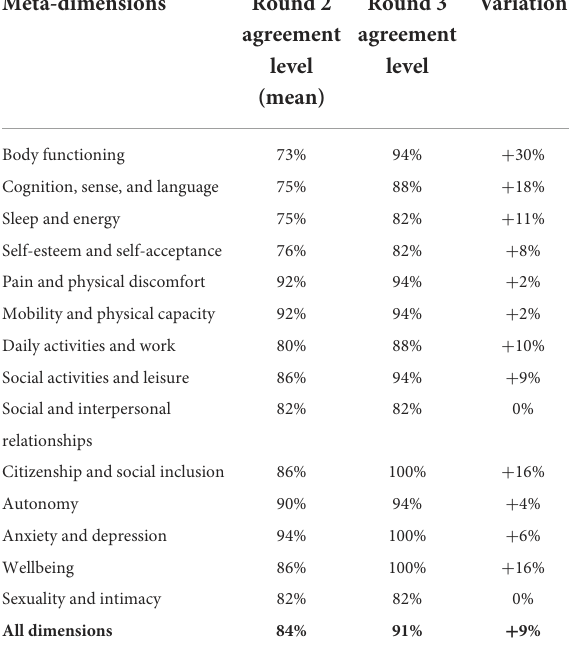
TABLE 4 Agreement variation between round 2 and round